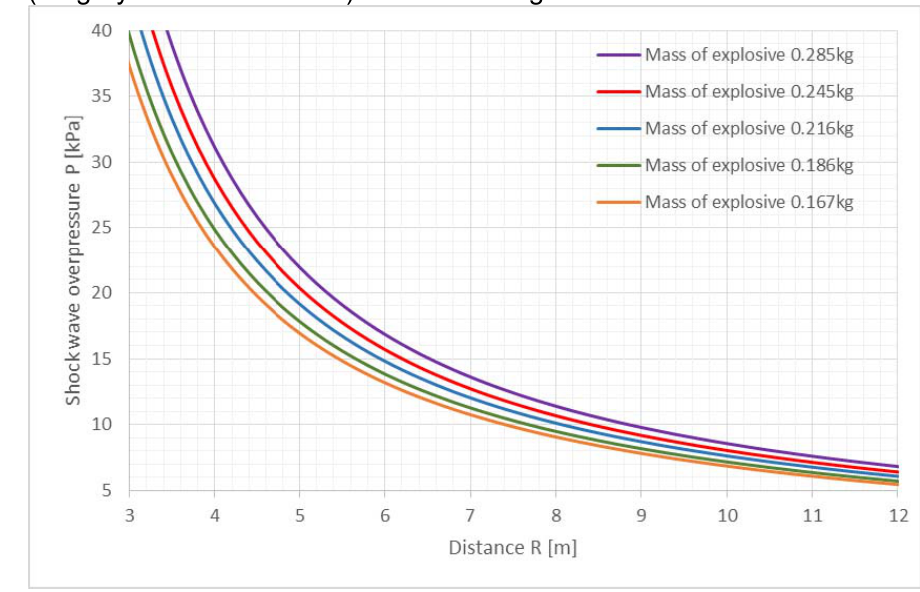
Figure 4 – Critical distance as a function of pressure in the case of temporary hearing loss Рис . 4 – Критическое расстояние в зависимости от давления в случае